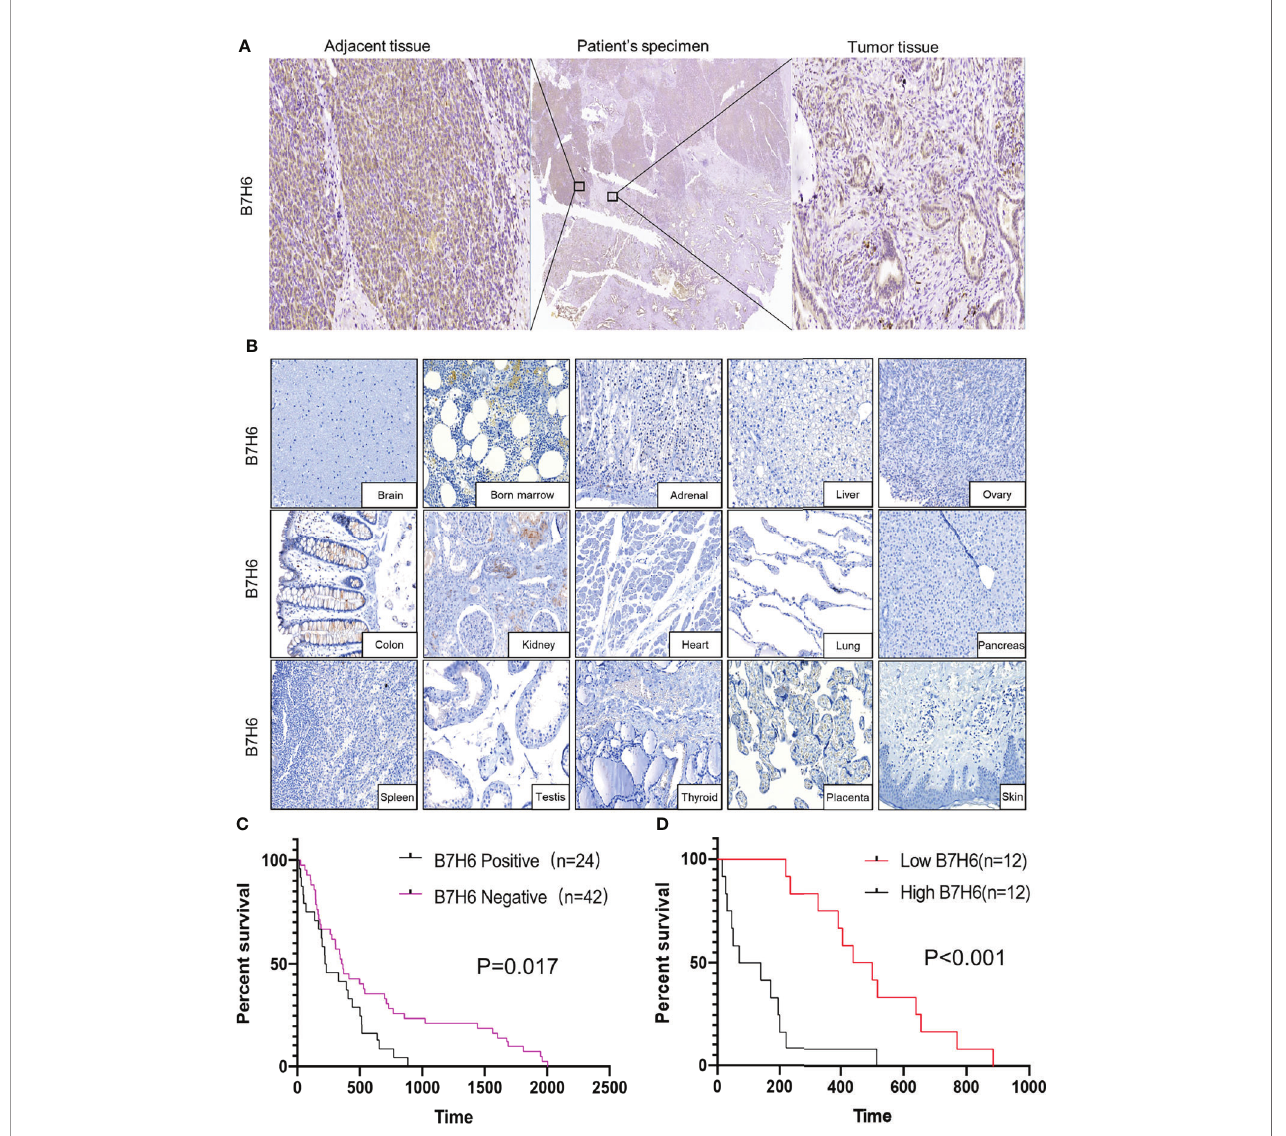
FIGURE 1 | B7H6 expression in human pancreatic cancer tissues. (A) IHC staining of B7H6 in tumor (right) and adjacent tissues (left) of a pancreatic cancer patient ’ s specimens (magni fi cation: Middle, 10×; right and left, 100×). (B) B7H6 expression in benign human organs shown by IHC staining of B7H6 (magni fi cation: 100×). (C) Kaplan-Meier survival analysis of overall survival between PC patients who carried B7H6-positive or -negative tumors. P =0.017. (D) Kaplan-Meier analysis of overall survival between patients with high levels of B7H6 (H score ≥ 47) and those with low levels (H-score < 47). P